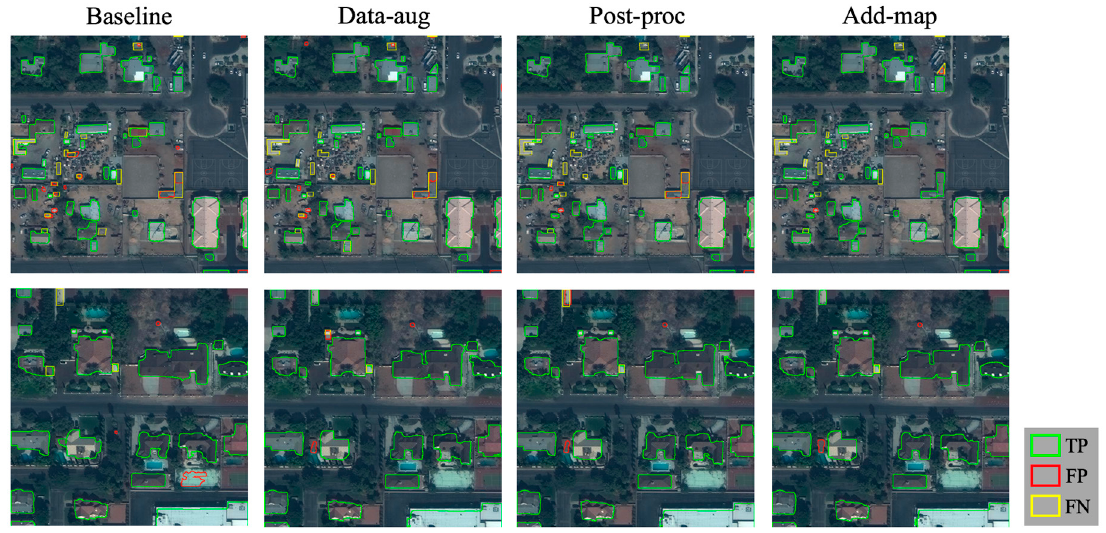
Remote Sens. 2019 , 11 , x FOR PEER REVIEW Figure 6. Examples of building extraction results for Las Vegas using different strategies.